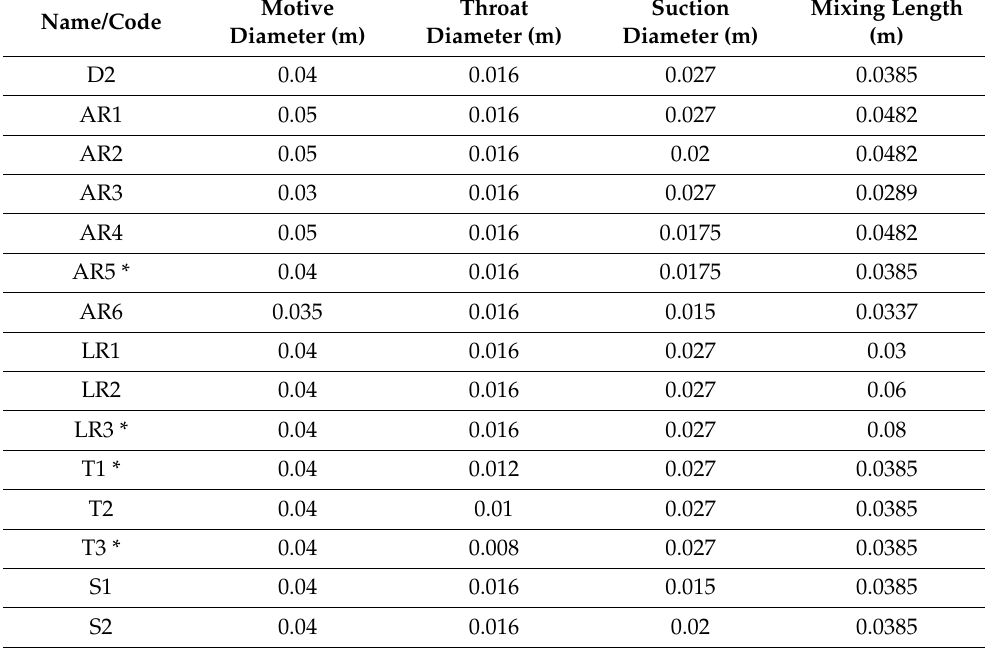
Table 3. Summary of nozzle geometries in parametric study. The AR code refers to the area ratio being varied while all other geometric parameters were held constant. Similarly, the LR, T, and S codes refer to varying the length ratio, throat diameter, and suction inlet diameter,